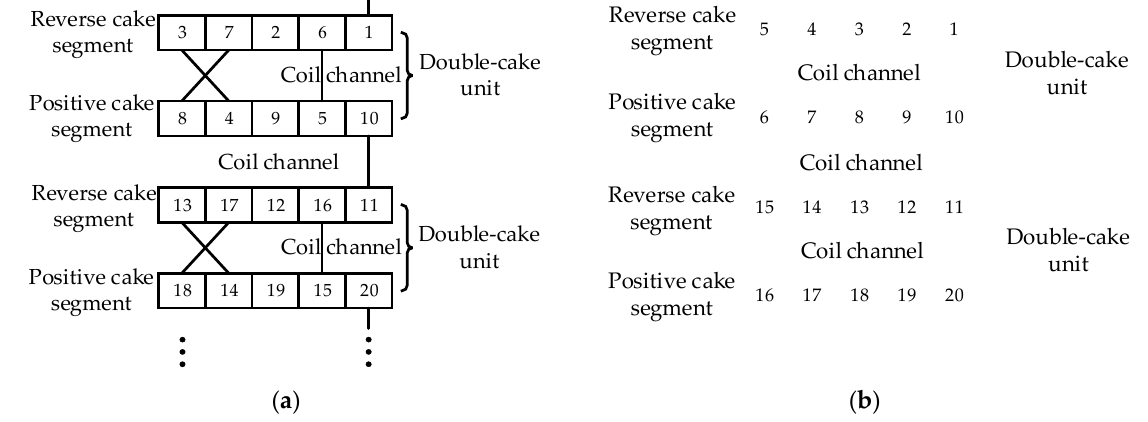
Figure 5. Outspread diagram of winding. ( a ) Interleaved windings; ( b ) Continuous windings.